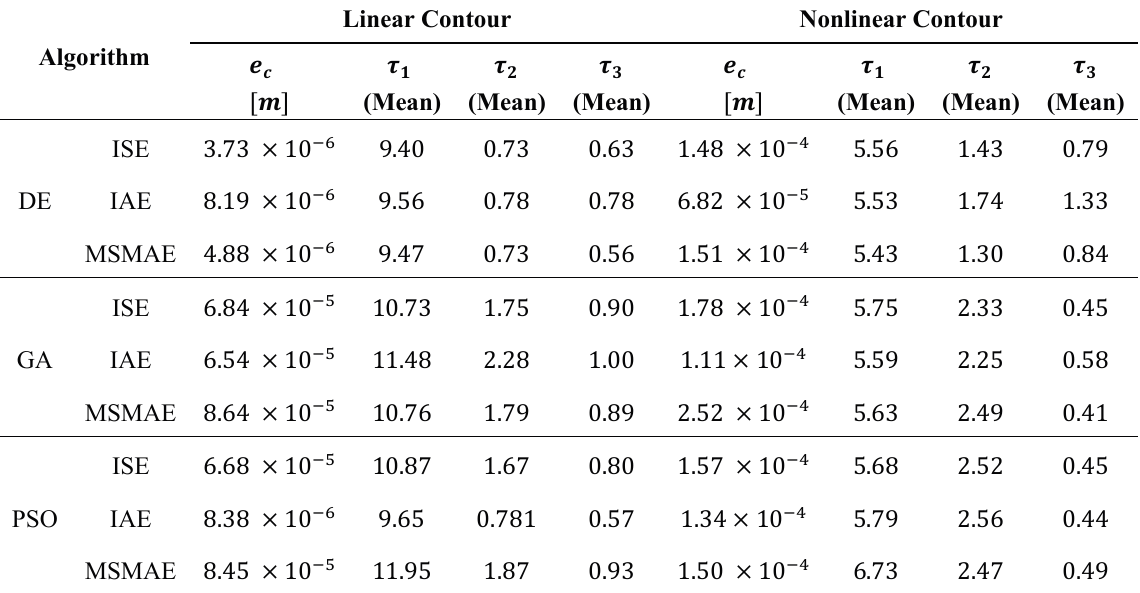
Table 8 . Resulting contour errors and mean